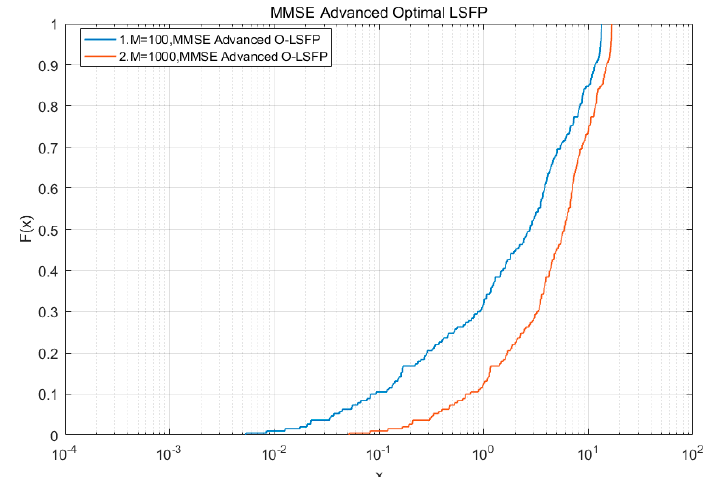
Figure 8. CDF of MMSE-A-O-LSFP channel can achieve.